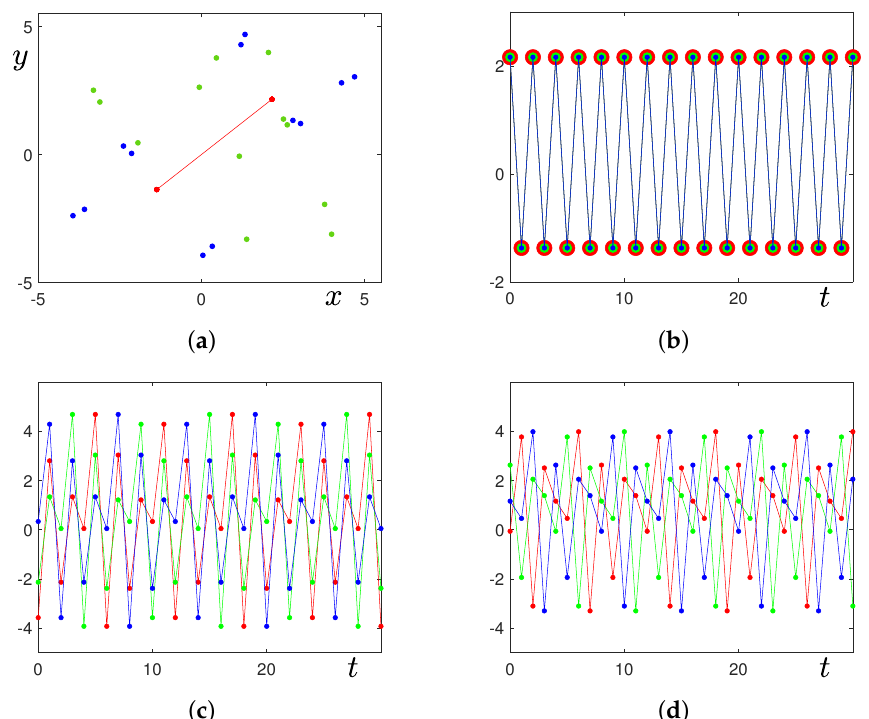
Figure 5. Coexisting cycles in system (1) for σ = 0.8. ( a ) Projections of coexisting 2-cycle (red line) and two 12-cycles (blue and green dots) on the ( x , y ) plane. Time series of ( b ) completely synchronized 2-cycle ([30]-pattern), ( c ) phase synchronized 12-cycle ([010101010101]-pattern), and ( d ) asynchronous 12-cycle ([011001100110]-pattern).